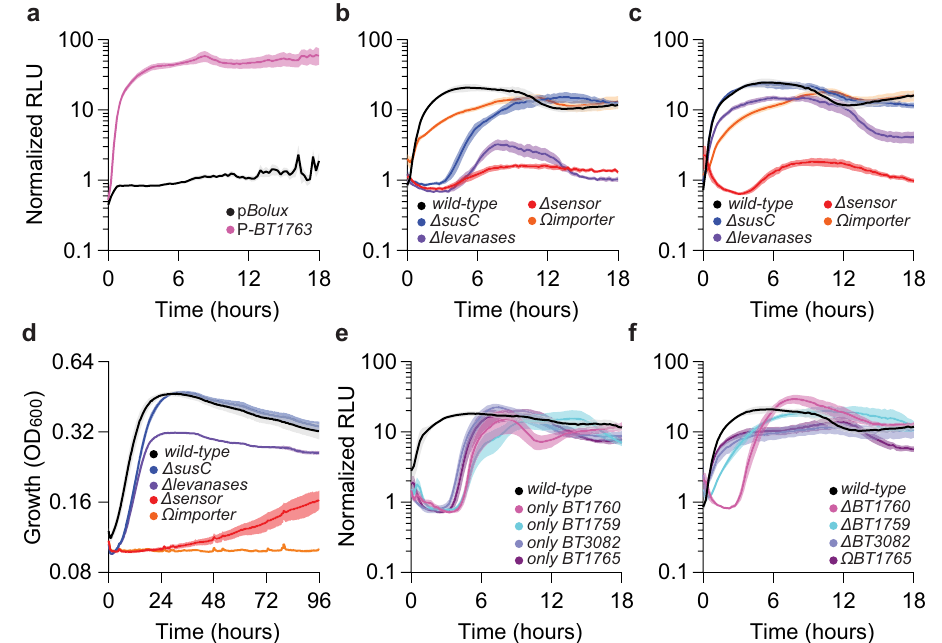
Fig. 4 | A levan-responsive reporter reveals multiple levanases coordinate fructan utilization in Bt. a Relative luminescence from wild-type Bt harboring p Bolux (black) or a plasmid including the promoter region preceding the levan- inducible susC gene(P- BT1763 ,pink)followingtheintroductionoflevanasthesole carbon source and normalized by the relative luminescence of identical cultures suppliedgalactose.Valuesarethemeanof12biologicalreplicatesanderrorisSEM in color-matched shading. b, c Relative luminescence from wild-type Bt (black) or strainslackingthelevan-inducible susC ( Δ BT1763 ,blue),4levan-speci fi chydrolases ( Δ BT1760-1759 Δ BT3082 Ω BT1765 , purple), fructan sensor ( Δ BT1754 , red), or a putative inner-membrane fructose transporter ( Ω BT1758 , orange) harboring P- BT1763 weremeasured following the introduction of anequalmixture ofgalactose and ( b ) levan or ( c ) fructose and normalized by the relative luminescence of identical cultures supplied galactose alone. d Growth of wild-type Bt (black) or strainslackingthelevan-inducible susC ( Δ BT1763 ,blue),4levan-speci fi chydrolases